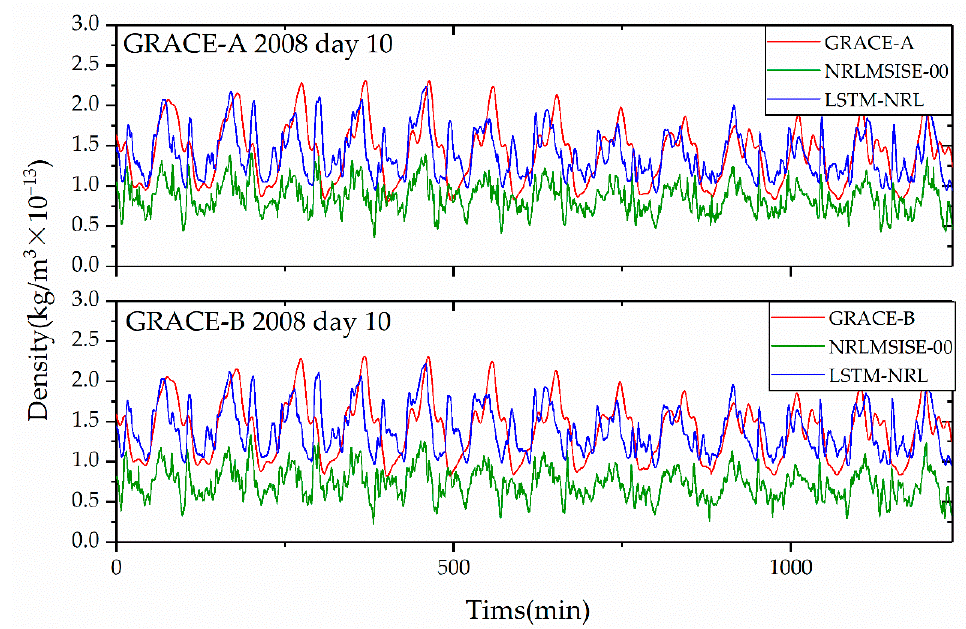
Figure 8. The density series along the GRACE orbits on day 10 of 2008. It can be seen that the density calibrated by the LSTM-NRL (blue lines) is closer to the “true” density (red lines) than the density computed from the NRLMSISE-00 (green lines) on the two days for both GRACE-A and GRACE-B. Both in the general trends and at extremes, the densities from the LSTM-NRL are highly consistent with the “true” densities. The LSTM-NRL shows significant calibration effect on the NRLMISISE-00 densities